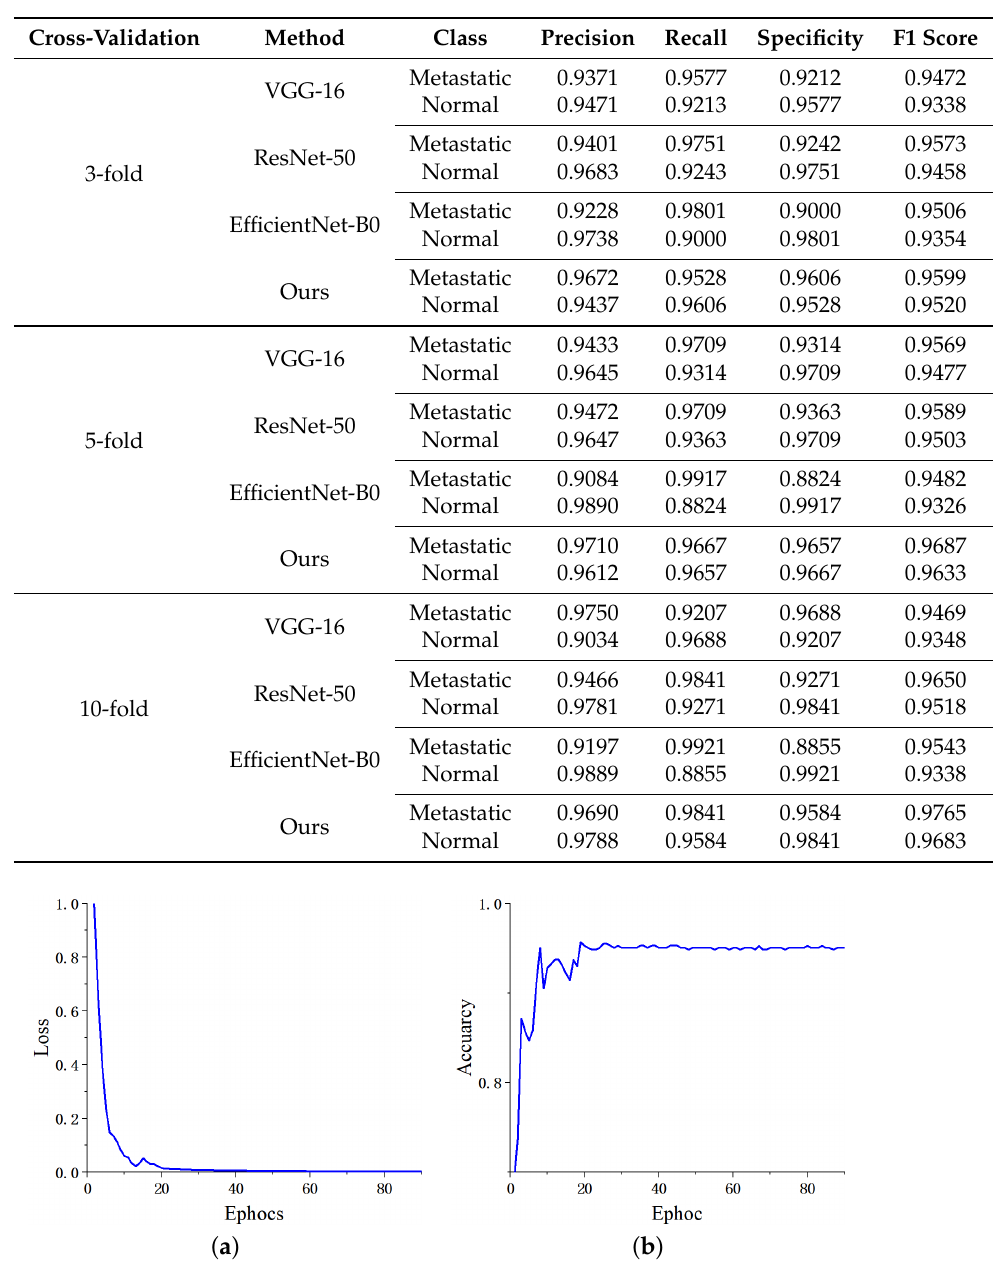
Figure 14. The curves of the training process on dataset BT-2C. ( a ) Training loss, ( b ) validation